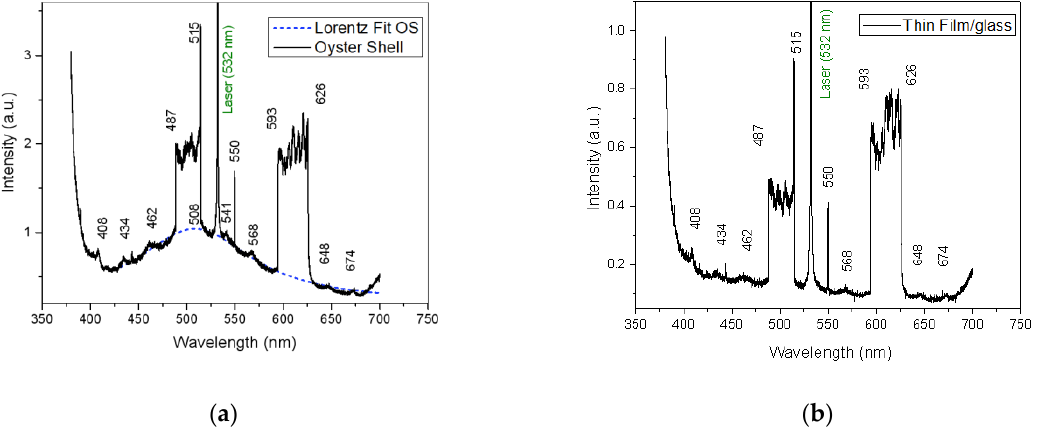
Figure 6. Laser-induced fluorescence spectra, 30 ns delay of the oyster shell used as target ( a ) and of the thin film deposited on glass slab ( b ). the thin film deposited on glass slab ( b